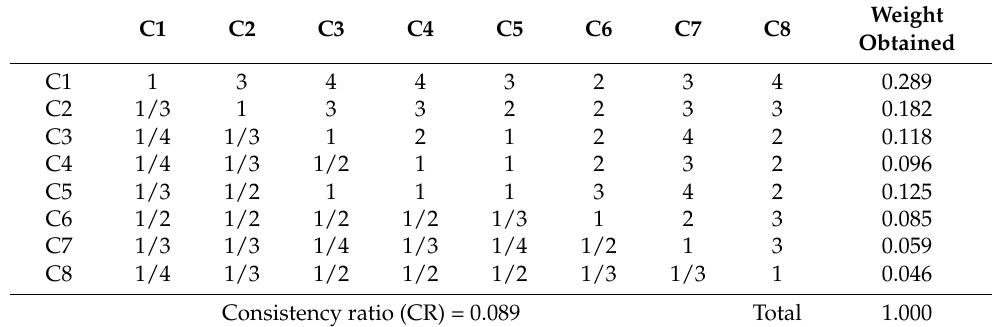
Table 4. Relative matrix importance of the criteria, CR and weights obtained for the criteria for determining the risk of water shortages.